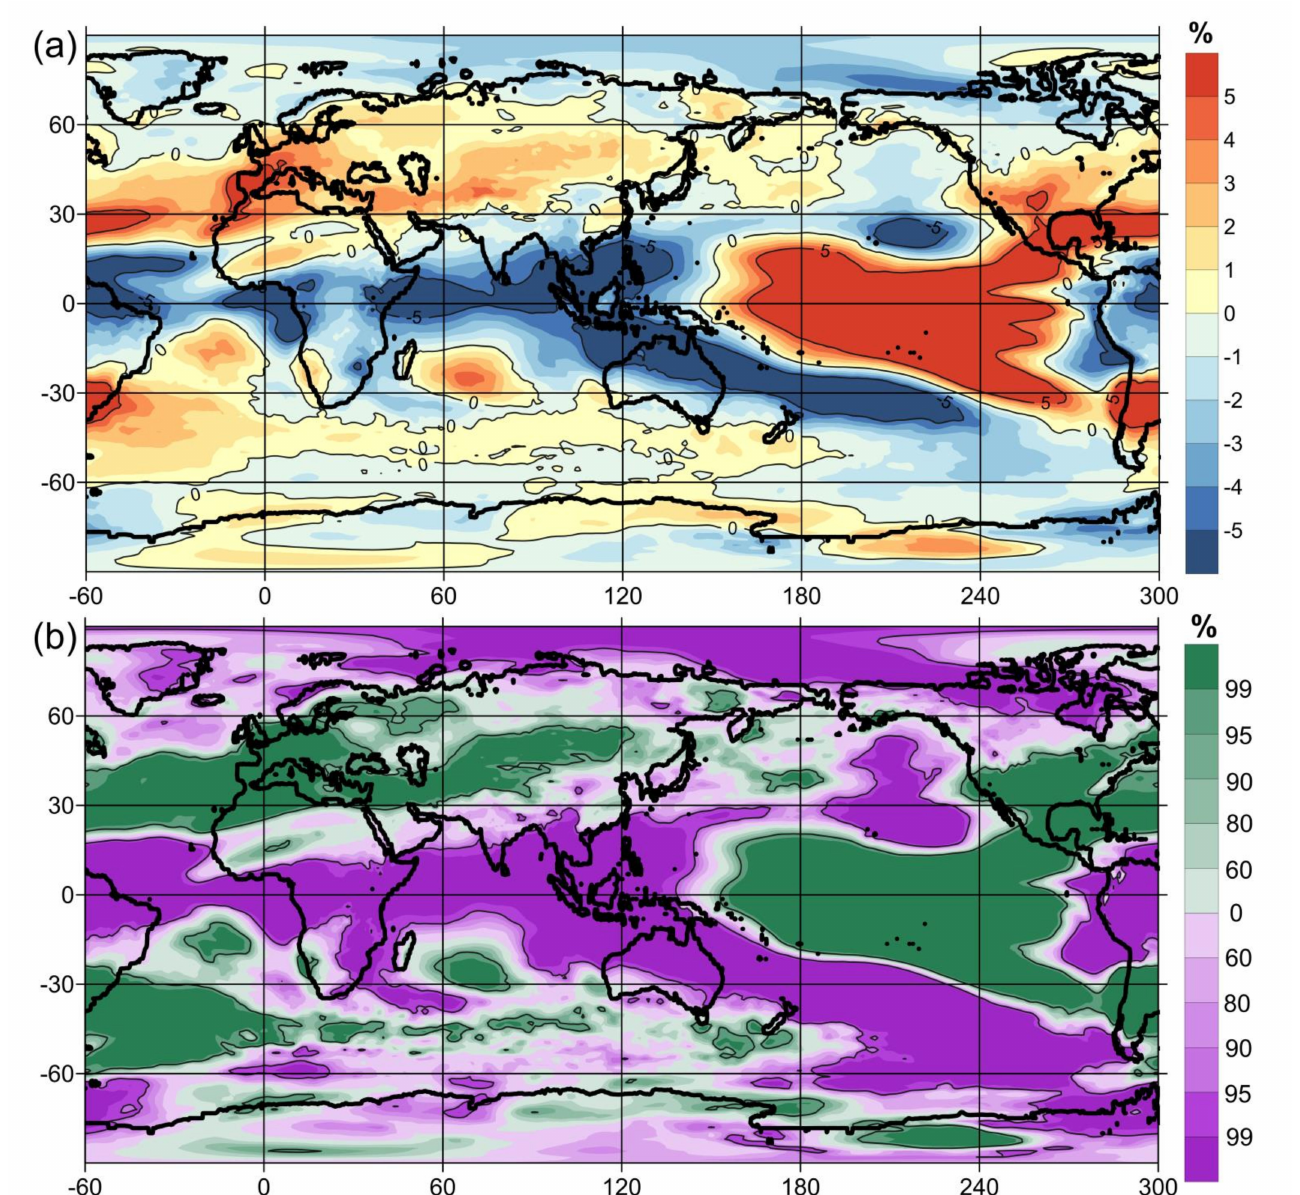
Figure 9. The difference in average total cloud cover anomalies between opposite phases of the Global Atmospheric Oscillation by GAO2 index ( a ). The probability values for ( a ) according to Student’s t -test ( b